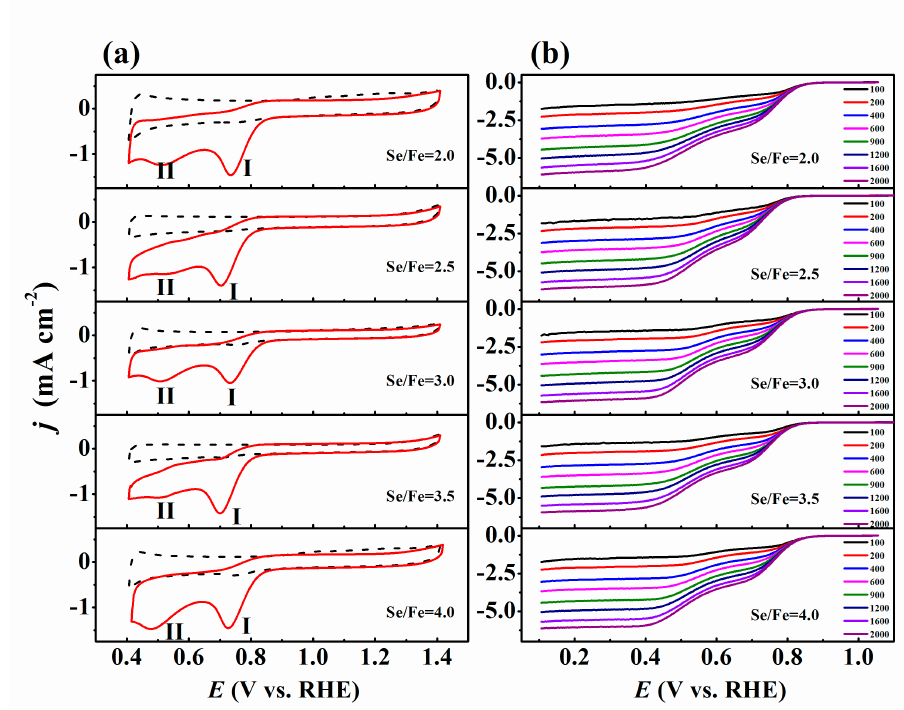
Figure 3. Cyclic voltammograms at 50 mV·s − 1 ( a ) and RDE polarization curves at 5 mV·s − 1 ; ( b ) of FeSe 2 /C prepared with different Se/Fe ratios in N 2 (dashed lines) and O 2 (solid lines) saturated 0.1 mol·L − 1 KOH solutions.